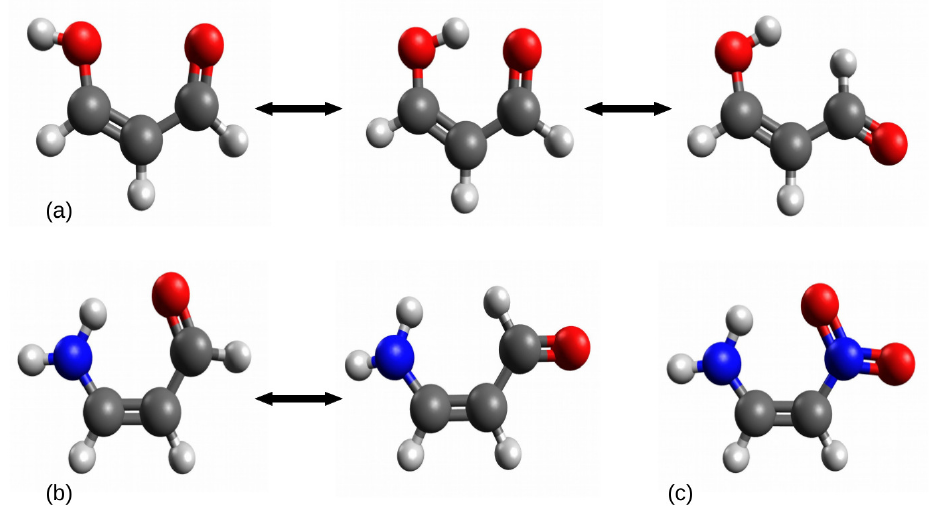
Figure 3. Examples of problematic cases in the open-closed method: ( a ) malondialdehyde, ( b ) 3-aminoacrolein, ( c )